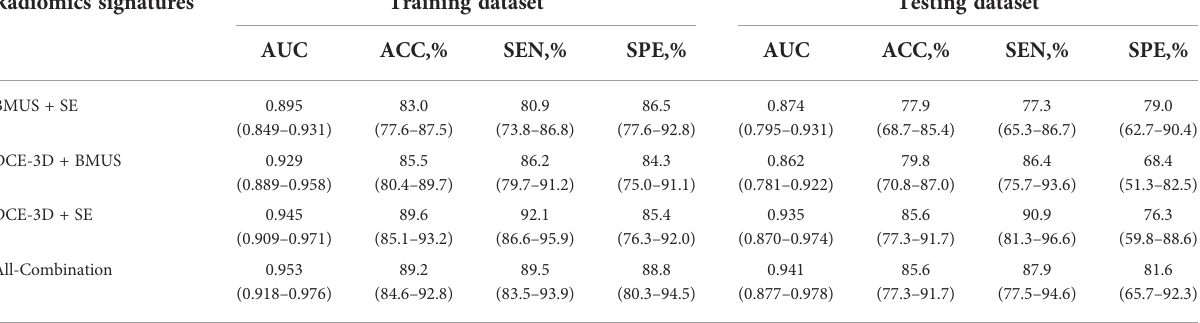
TABLE 3 The diagnostic performance of multi-modality radiomics signatures.